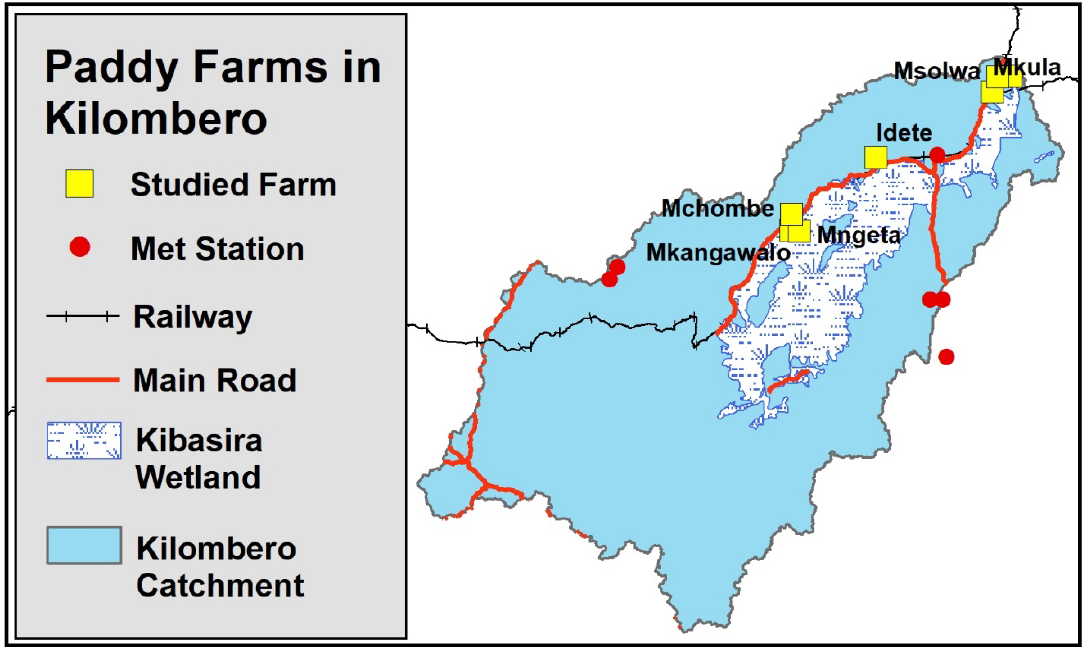
Figure 1. Map of Kilombero River Catchment illustrating surveyed sites (villages and KPL farm). The catchment borders the Udzungwa Mountains ranges to the north-western border of the catchment. The mountain rises to an elevation of 2576 m.a.m.s.l forming an im- 1516 m.a.m.s.l, and the Mahenge escarpment forms the north-eastern border of KRC (the